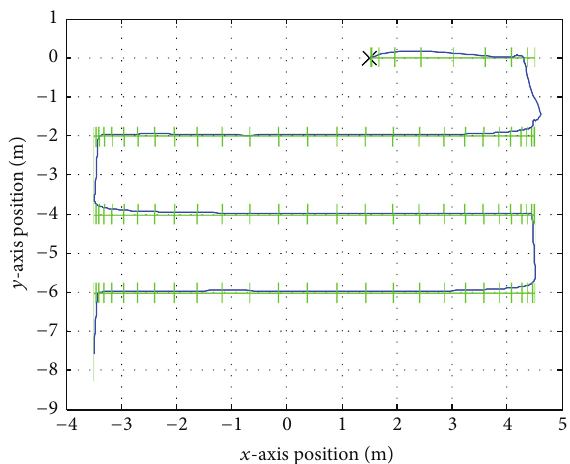
Figure 4: Planar view for conventional region tracking control.